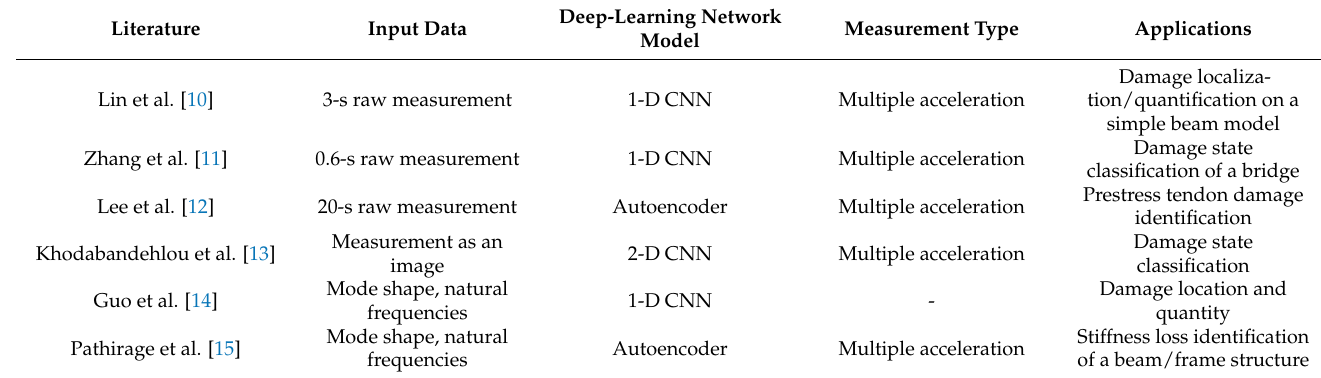
Table 1. Deep neural network for vibration-based structural damage